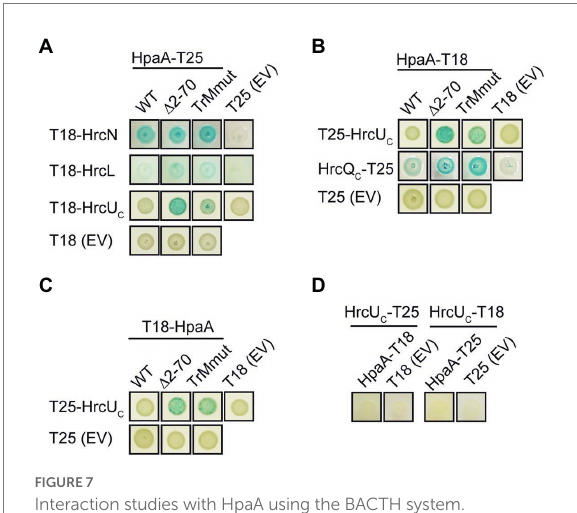
FIGURE 7 Interaction studies with HpaA using the BACTH system. (A) Interaction studies with HpaA, HrcN, HrcL and the cytoplasmic domain of HrcU. Expression constructs encoding T18 fusions of HrcN, HrcL and the cytoplasmic domain of HrcU (HrcU C ) and T25 fusions of HpaA, HpaA or HpaA TrMmut were ∆ 2–70 transferred to E. coli BTH101 cells as indicated. As controls, bacteria were cotransformed with T18 or T25 fusion constructs and the corresponding empty vectors (EV) encoding T18 or T25 as indicated. Bacterial cultures were grown on indicator plates and photographs were taken after 5 days. One representative colony per interaction is shown. Cotransformations were performed three times. At least three different transformants for every combination were analysed in every experiment with similar results. All proteins were stably synthesized as is shown in Supplementary Figure S4. (B) Mutations in the N-terminal region of HpaA promote the interaction with HrcU C and HrcQ C . Interactions between T18 and T25 fusions containing HpaA, HrcU C and HrcQ C as indicated were analysed in BTH101 cells. Bacterial cultures were grown on indicator plates and the results of the interaction assays were documented as described in (A) . (C) An N-terminal HpaA deletion derivative interacts with HrcU C . BTH101 cells were cotransformed with expression constructs encoding T25, T25-HrcU C , T18 and T18 fusions of HpaA, HpaA ∆